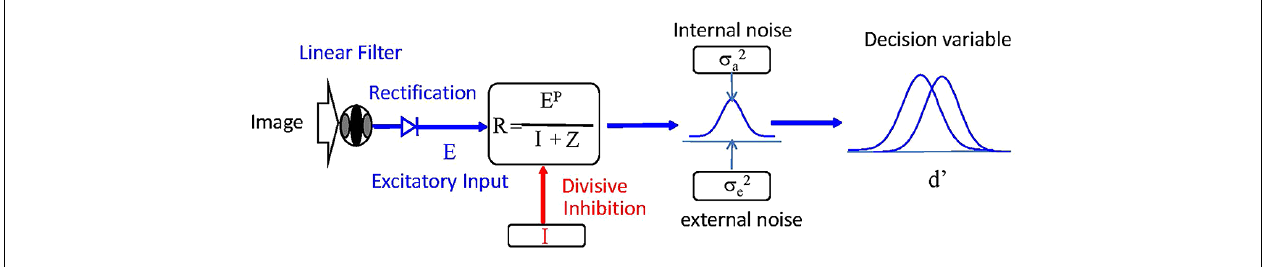
FIGURE 3 | Diagram of the model used to fit the data. See text for